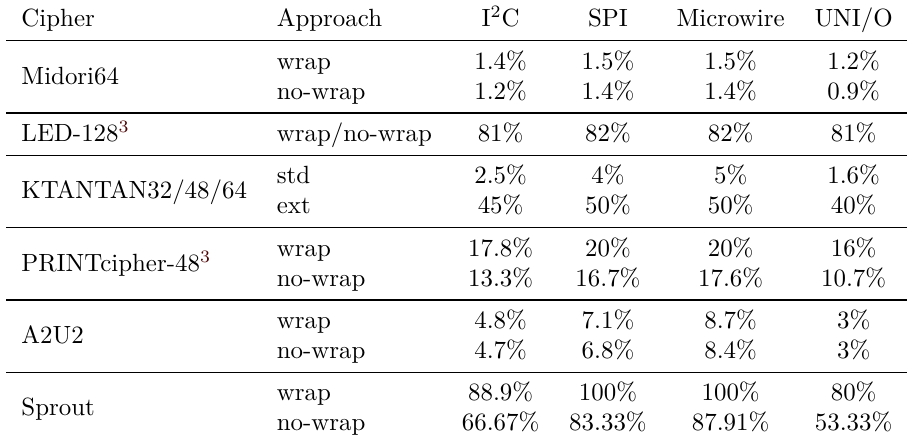
Table 2: Impact of different standard serial interfaces for EEPROM access on the through- put for several ciphers relative to the original throughput i. e., higher is better. Cipher Approach I 2 C SPI Microwire UNI/O